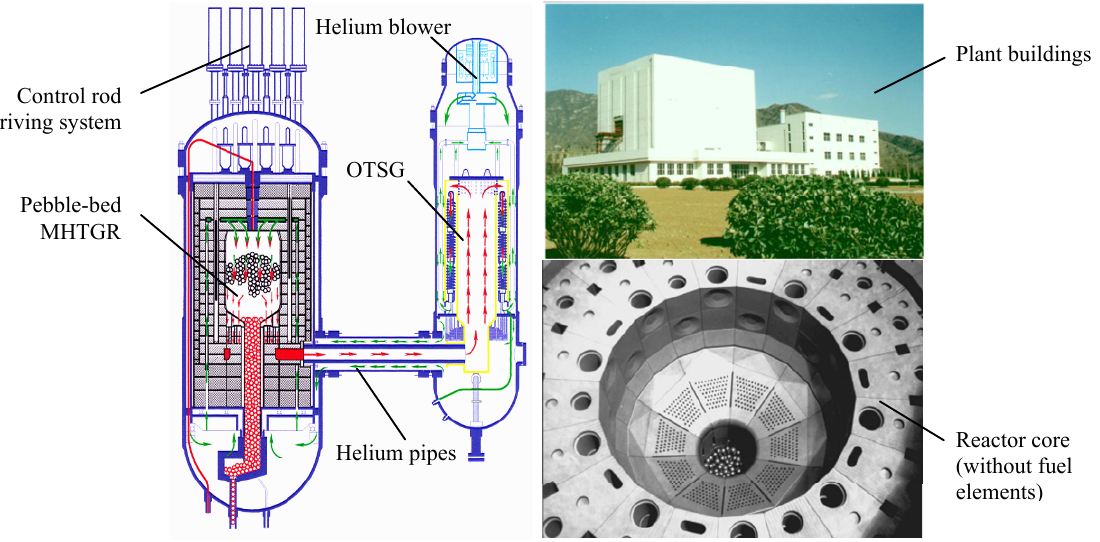
Figure 1. Schematic structure of the HTR-10.